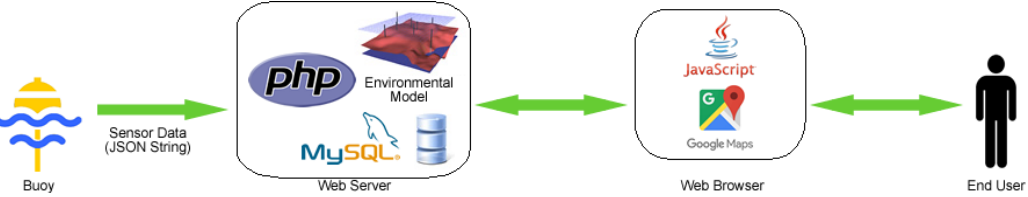
Figure 9. Software Architecture.